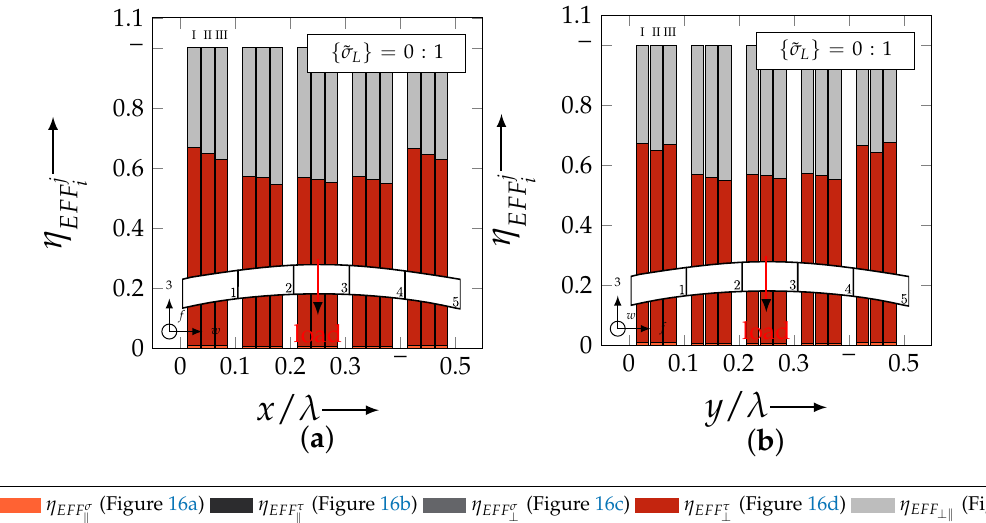
Figure 28. Illustration of the composition of FM by their fractions η the load path { ˜ σ L } = 0:1 for ( a ) weft and ( b ) fill yarn.